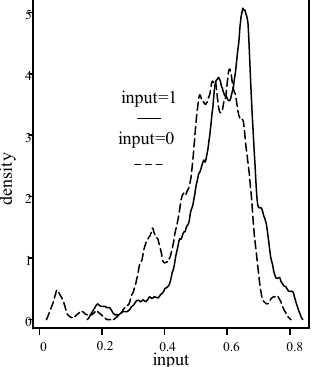
Figure 2. Overlapping test of improved fertilizer input.